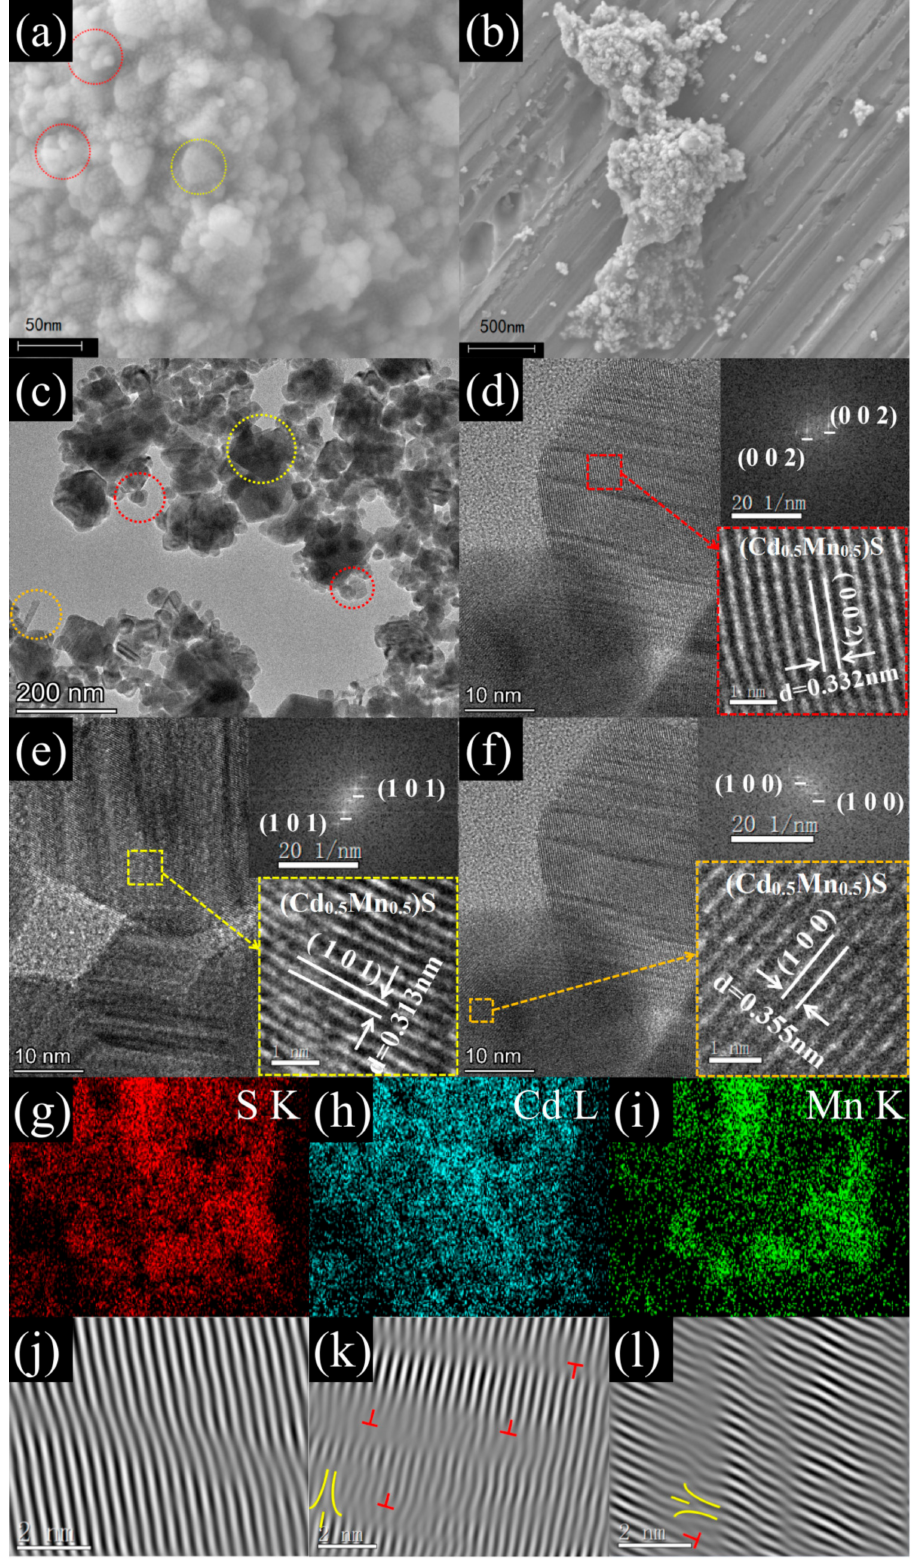
Figure 3. ( a , b ) SEM images of MCS-2 samples. ( c – f ) HRTEM image of the MCS-2. ( g – i ) EDX element mappings of MCS-2. ( j – l ) Inverse fast Fourier transform patterns of the (002), (101), and (100) planes of